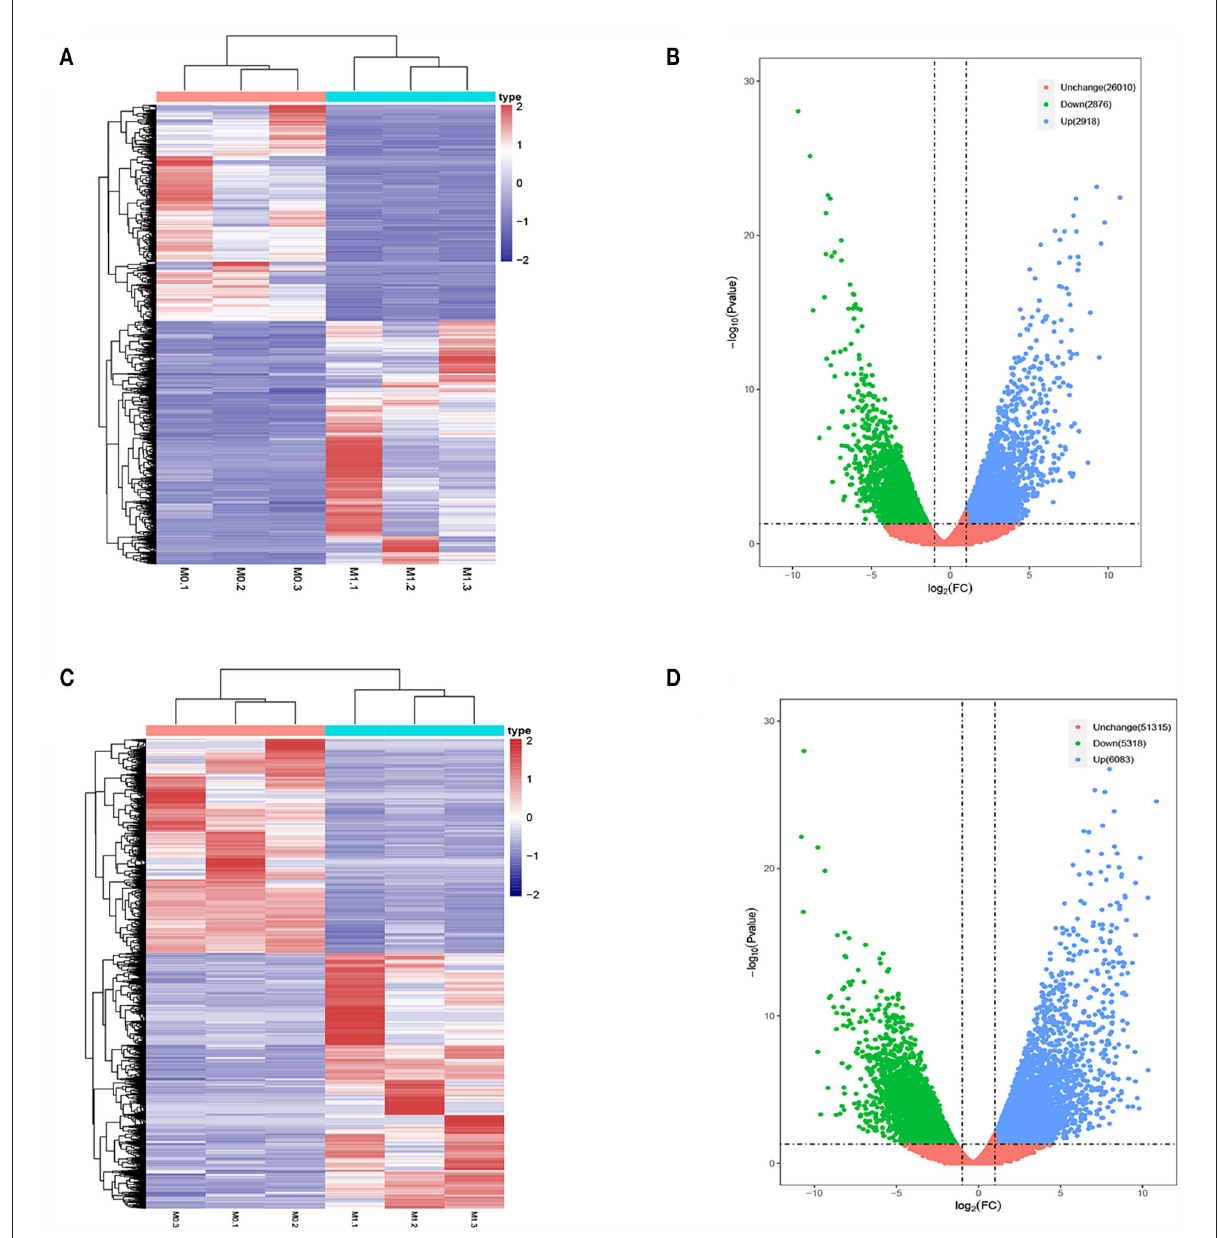
FIGURE1 Differentially expressed lncRNAs and mRNAs in M0-type macrophages and M1-type macrophages. (A) lncRNAs Heat map. M0-type macrophages (M0-1, M0-2, and M0-3) and M1-type macrophages (M1-1, M1-2, and M1-3). (B) lncRNA Volcano plot. (C) mRNA Heat map. M0-type macrophages (M0-1, M0-2, and M0-3) and M1-type macrophages (M1-1, M1-2, and M1-3). (D) mRNA Volcano plot. Green or blue points represent upregulated or downregulated lncRNAs/mRNAs (log2 FC > 1 and P < 0.05 and log2 FC< − 1 and P < 0.05) and red indicates no significant